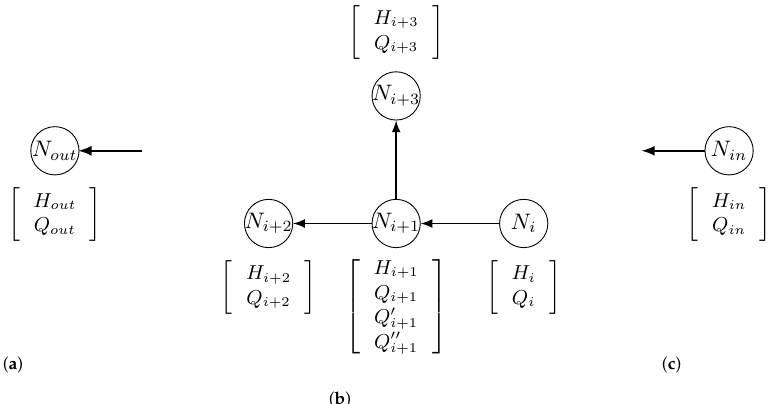
Figure 4. Atomic representation for an output, inner an input node. ( a ) Output Node; ( b ) Inner Node; ( c ) Input